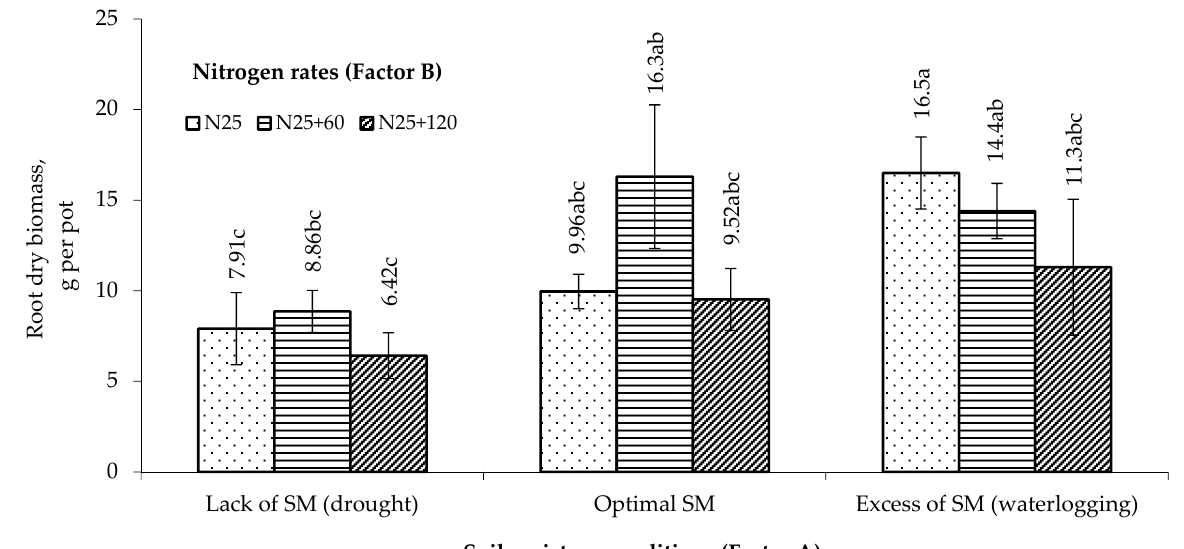
Figure 8. Root dry biomass of red clover and forage timothy mixture. Note. SM—soil moisture. The differences between the means of treatments, marked by different letters (a, b, c), are significant ( p < 0.05). Whiskers indicate standard errors of the means. Table 1. Nutritive Value of red clover and forage timothy